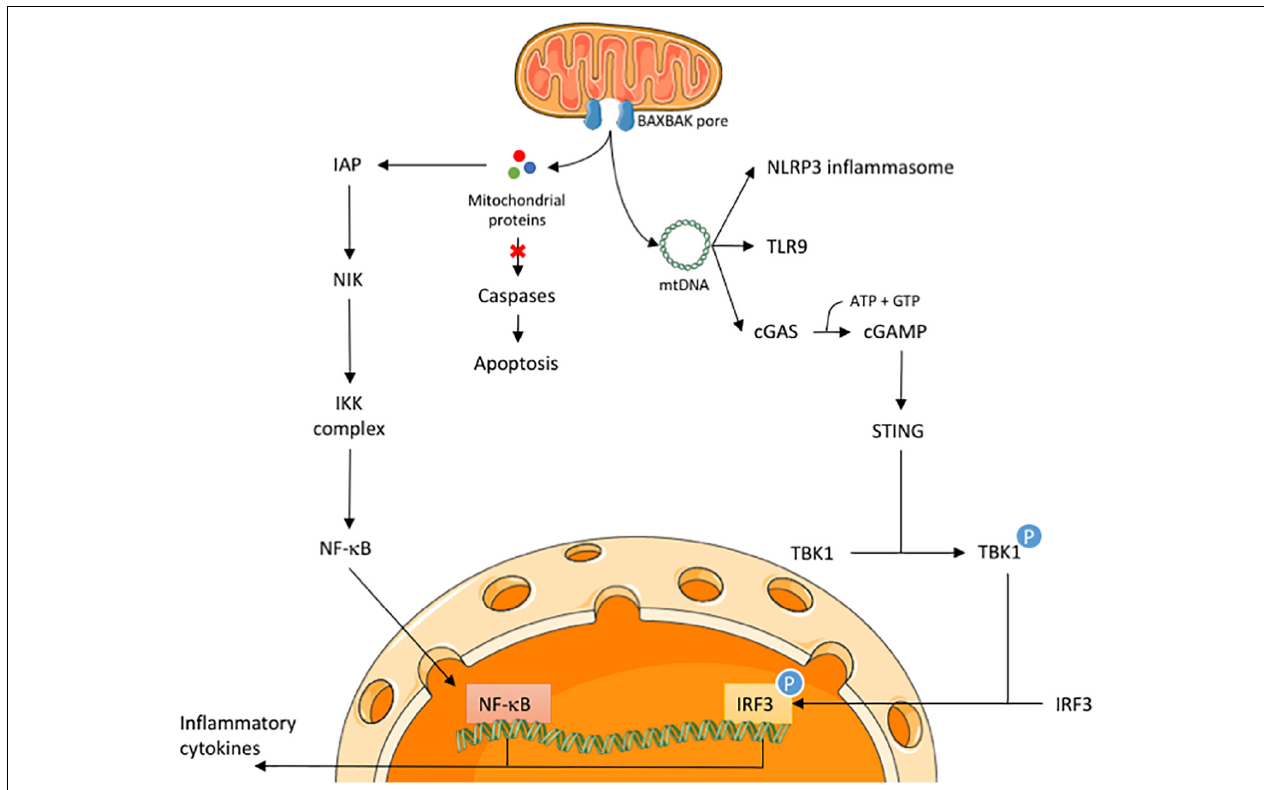
FIGURE 1 | Release of mitochondrial proteins and mtDNA initiates an inflammatory response in CICD. Upon an apoptotic trigger, BAX and BAK form pores in the mitochondrial membrane to allow the release of mitochondrial proteins, such as cytochrome c and SMAC/DIABLO, and mtDNA. During CICD, the release of mitochondrial proteins activates the NF- κ B pathway via a SMAC-like mechanism. In parallel, release of mtDNA may activate the NLRP3 inflammasome, TLR9 receptor and the cGAS-STING pathway. Activation of the latter will lead to nuclear translocation of IRF3 during CICD. Both NF- κ B and IRF3 engage the transcription of various inflammatory cytokines, leading to immune cell